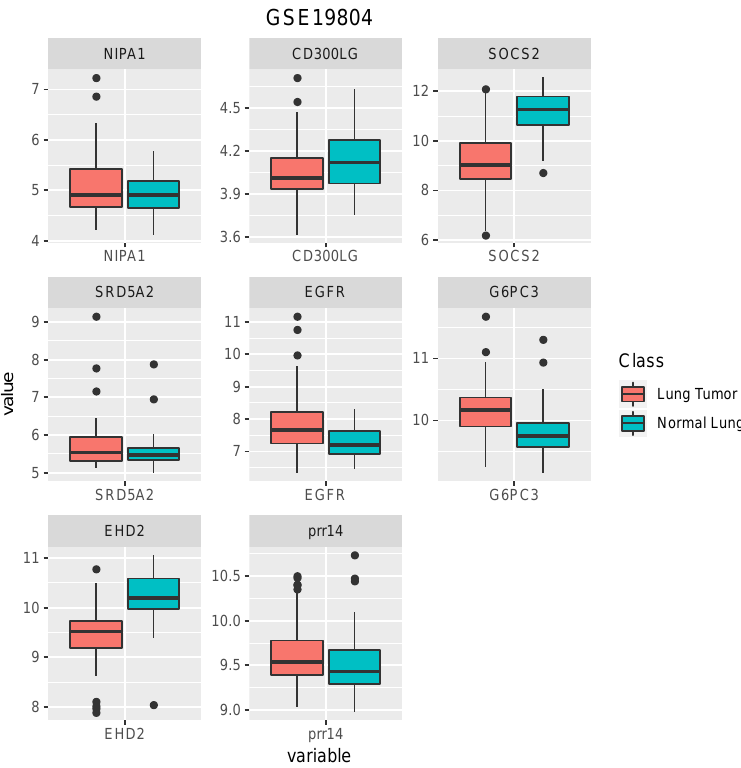
Figure 4. The box plots of selected genes by L 1/2 for dataset GSE19804.